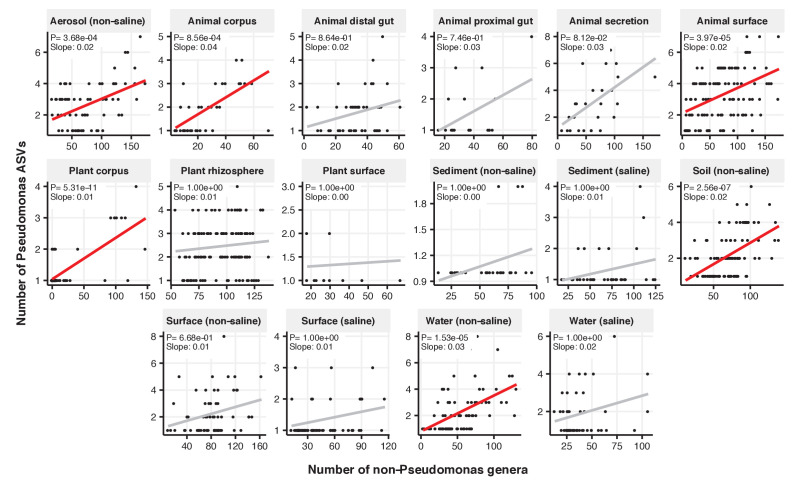
Focal-lineage diversity as a function of community diversity across biomes in Pseudomonas.Linear models are shown for ASVs per genus (y-axis) as a function of community diversity (non-focal genera, x-axis) in each of the 17 environments (EMPO3 biomes). Only environments containing the focal lineage are shown. Significant positive diversity slopes are shown in red (linear models, p<0.05, Bonferroni corrected for 17 tests), and non-significant in grey.